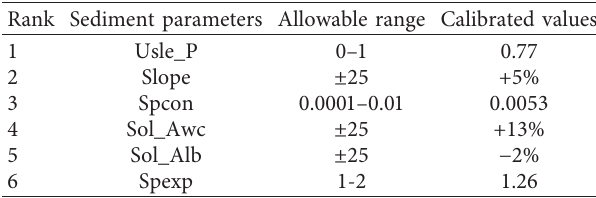
Table 13: Calibrated values for 1998 historical LULC. Table 14: Calibrated values for 2016 recent